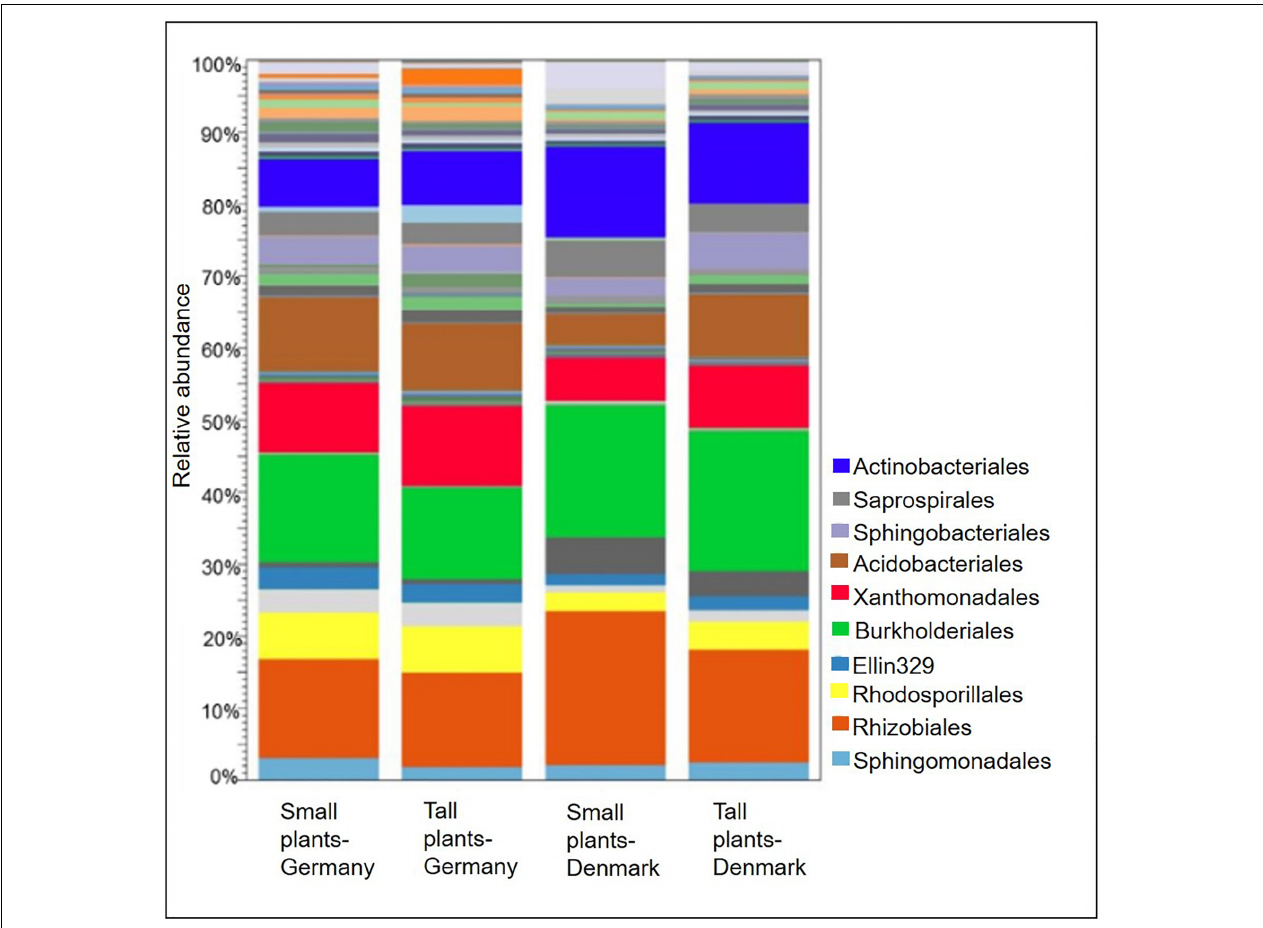
FIGURE 3 | Stacked bar plots showing relative abundances of bacterial orders in the rhizosphere of tall and small A. nordmanniana from German and Danish sampling sites. Plots are based on sequencing data for 16S rRNA genes.